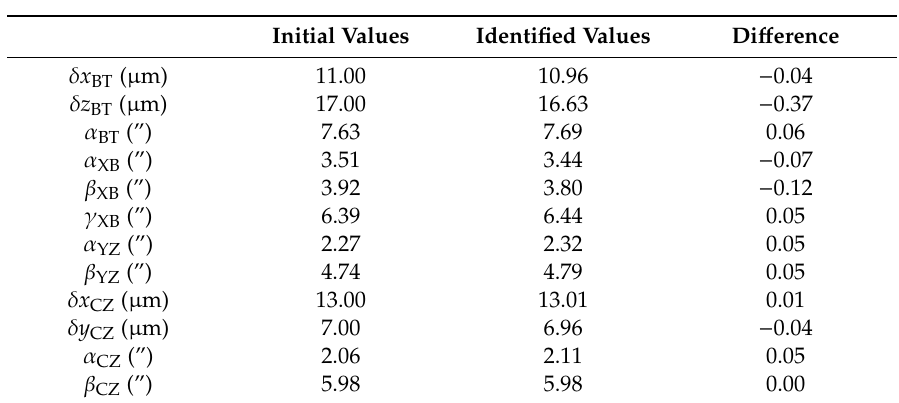
Table 7. Di ff erence between initial values and identified